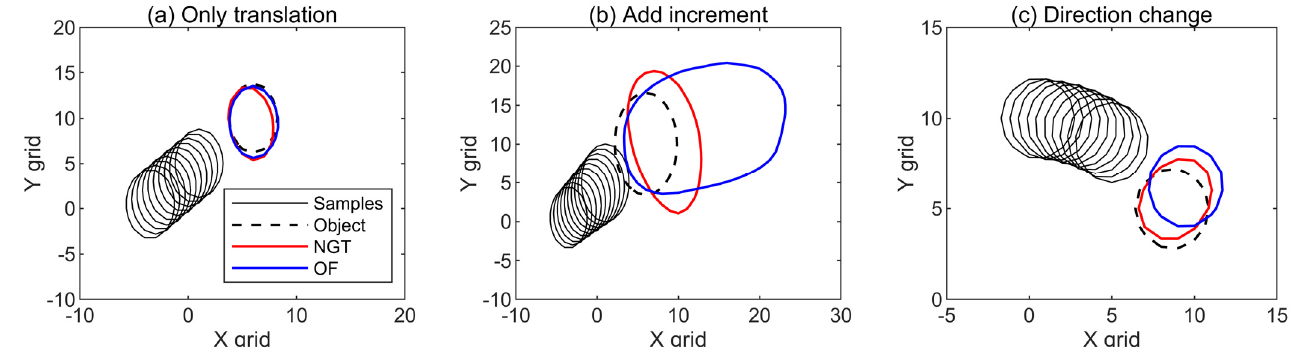
Figure 2. Example of extrapolation results in ideal experiments based on simple images: ( a ) only translation, ( b ) add increment, and ( c ) direction change. Samples are two-dimensional normal distribution images with an initial value range of 0~1, and contour lines for 0.5 are shown. The translation speed in ( a ) and ( b ) is 0.5 grids per time in both the X and Y directions. A 0.01 increment over time is added in ( b ). The rotation speed of the extreme center in ( c ) is 3 degrees per time. The historical samples shown are t = 1~10, the predictions start from t = 10, and the object is at t = 20. NGT is modeled using all ten historical samples, while OF uses only t = 9~10. The X and Y axes are distances with arbitrary